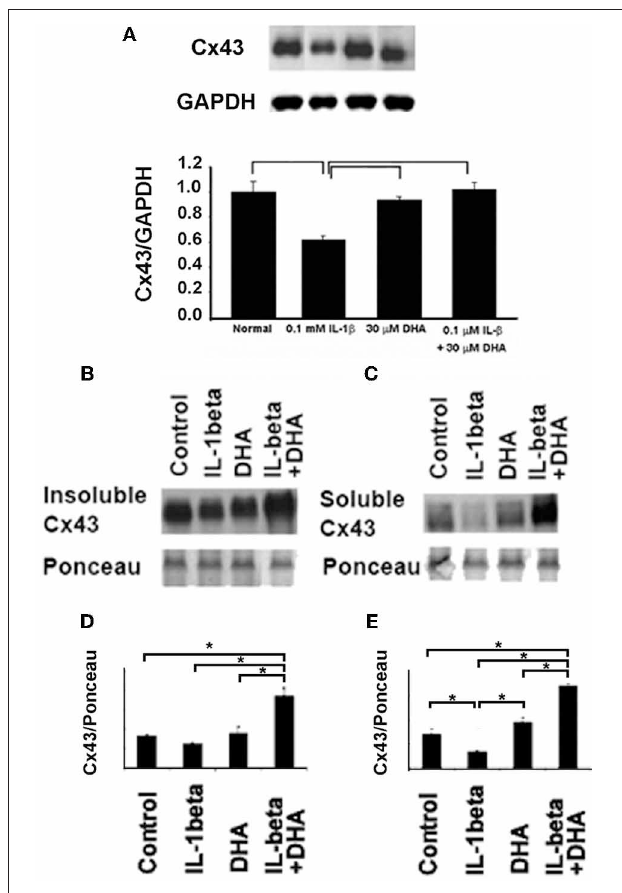
FIGURE 2 | Western-blotting results for the effect of DHA treatment on changes in total (A) membrane (B), and cytoplasmic (C) Cx43 in neonatal rat ventricular myocytes (NRVM). IL-1 β application led to a significant loss of total Cx43 (A) . This loss was seen in both soluble and insoluble fractions ( B and C ). DHA inhibited this effect. Quantification of the insoluble (D) and soluble (E) Cx43 fractions is shown below. Ponceau staining was used as a loading control. Densitometry of the bands ( n = 3) is shown p < 0 . 05.